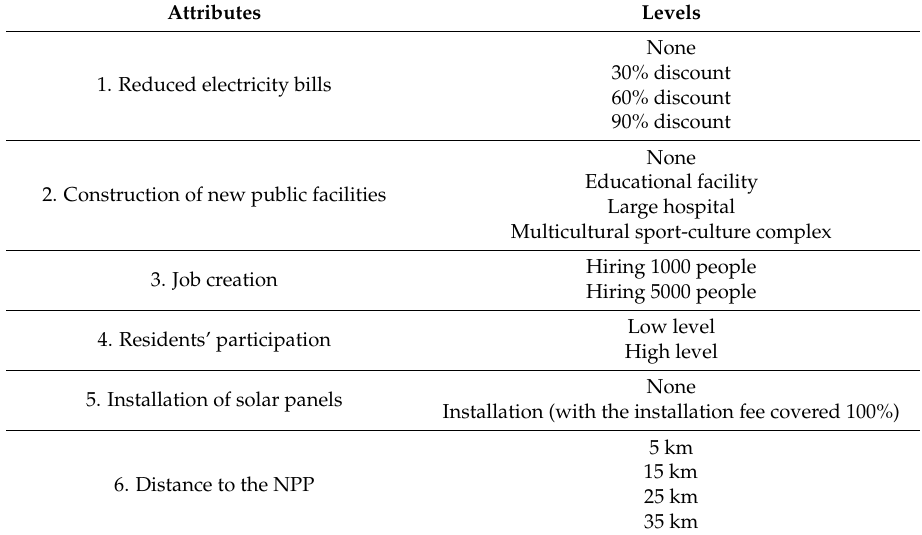
Table 1. Attributes and levels in the DCE: Construction of a new nuclear power plant and